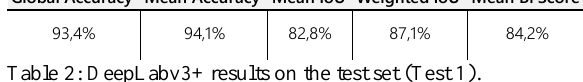
Table 3: DeepLabv3+ results on the test set for all the other buildings (Test